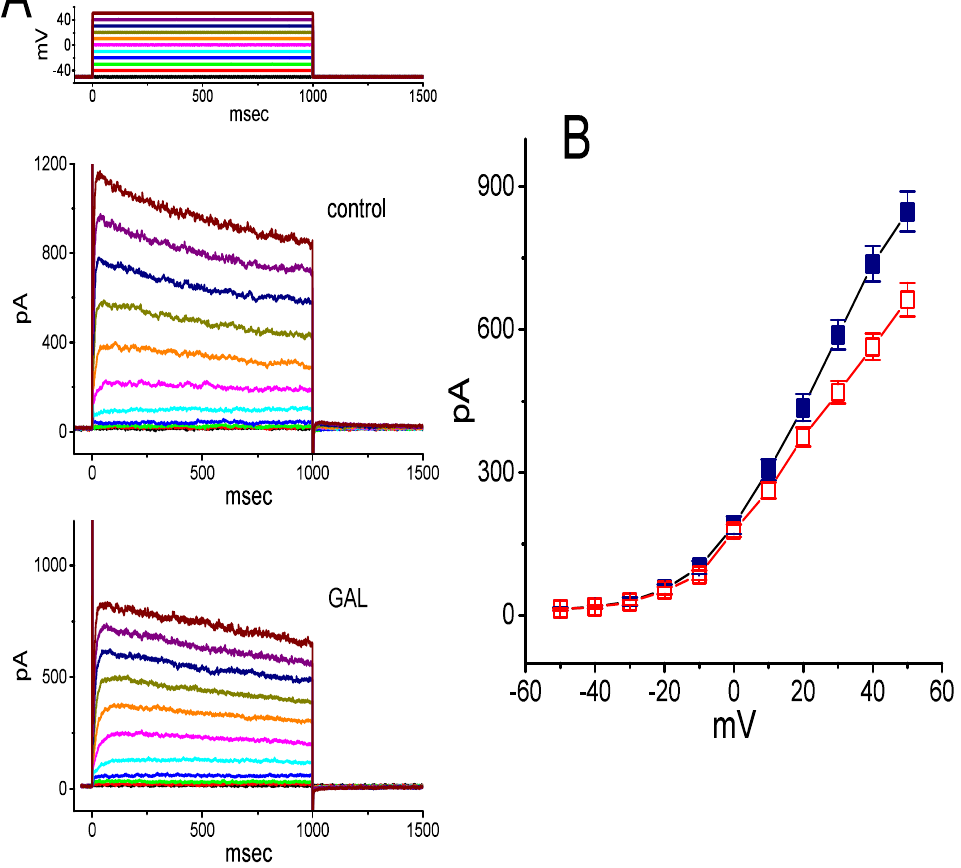
Figure 7. Mild inhibitory e ff ect of GAL-021 on delayed-rectifier K + current ( I K(DR) ) in GH 3 cells. In these experiments, we bathed cells in Ca 2 + -free, Tyrode’s solution which contained 1 µ M tetrodotoxin and 0.5 mM CdCl 2 . The holding potential was − 50 mV and clamp pulses to a series of voltage steps ranging between –50 and + 50 mV with a duration of 1 sec (as indicated in the uppermost part of (A) were applied. ( A ) Representative I K(DR) traces recorded in the absence (upper) and presence (lower) of 10 µ M GAL-021. ( B ) Averaged I-V relationships of I K(DR) obtained in the control ( (cid:4) ) and during cell exposure to 10 µ M GAL-021 ( (cid:3) ). Current amplitude was measured at the end of each voltage step, and each data point represents the mean ± SEM ( n = 7). Of note, GAL-021 at a concentration of 10 µ M mildly suppresses I K(DR)